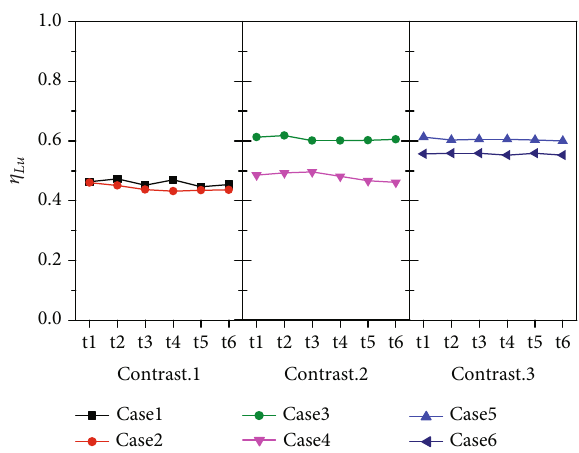
Figure 16: Icing similarity rate under di ff erent working